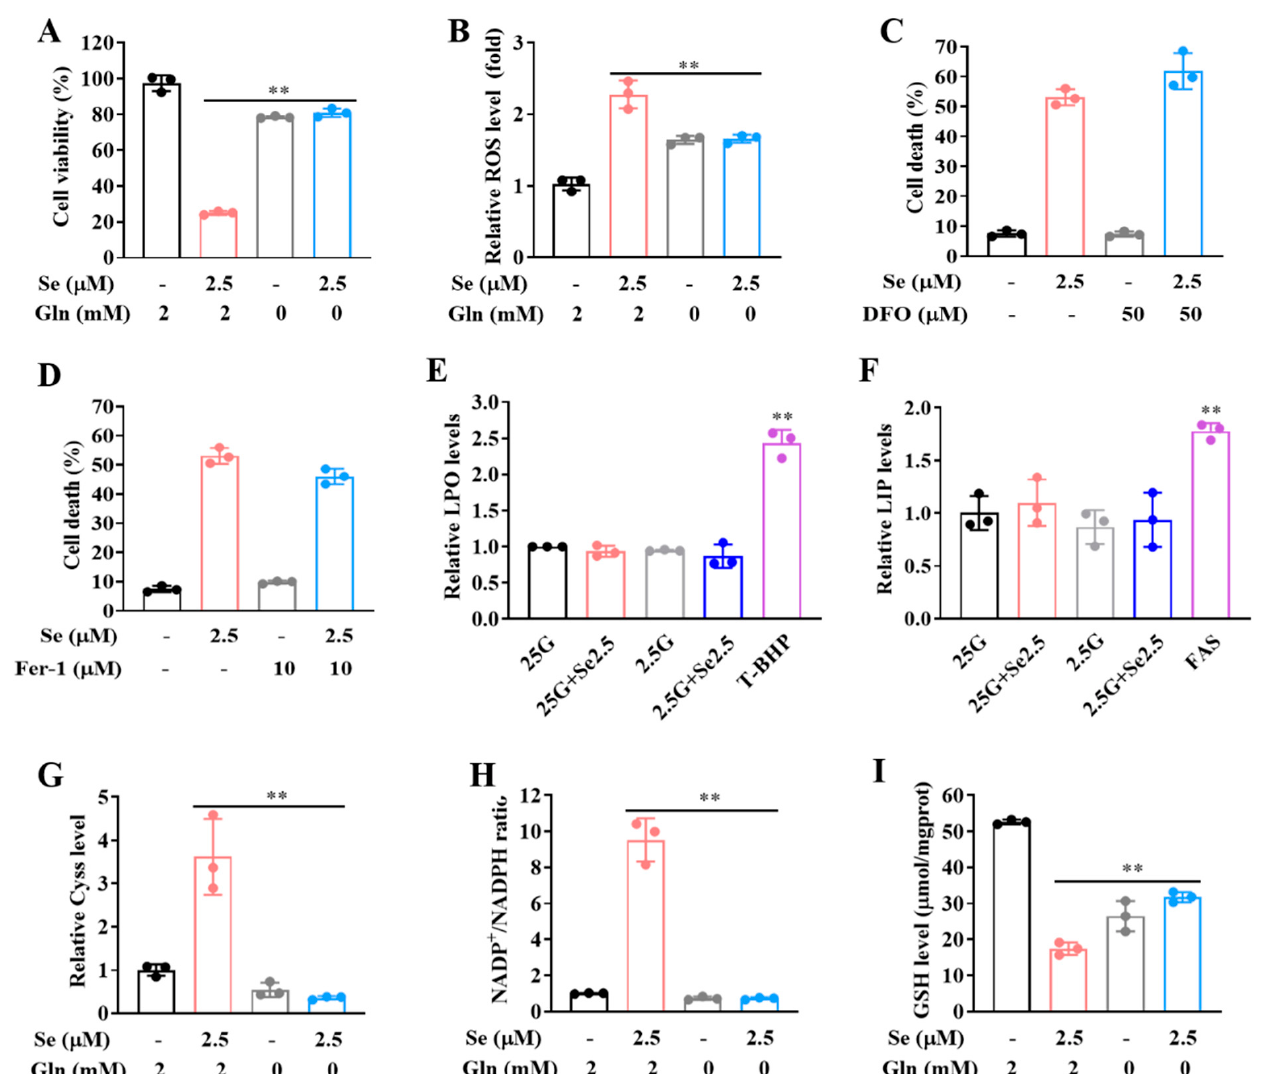
Figure 5. Selenite/glucose deprivation ‐ induced cytotoxicity is independent of ferroptosis. ( A , B ) Cell viability ( A ) and O 2 •− levels ( B ) of HCT116 cells cultured in the medium containing 2.5 mM glucose with or without treatment of selenite or glutamine deprivation for 24 h ( A ) and 22 h ( B ). ( C , D ) Cell death of HCT116 cells cultured in the medium containing 2.5 mM glucose with or without treatment of selenite or DFO or Fer ‐ 1 for 24 h. ( E , F ) LPO levels ( E ) and LIP levels ( F ) of HCT116 cells cultured in the medium containing 2.5 mM glucose with or without treatment of selenite for 22 h. Cells cultured in the medium containing 2.5 mM glucose were treated by 1 mM T ‐ BHP or 200 μ M FAS for 30 min before detection. ( G – I ) Cyss levels ( G ), NADP+/NADPH ratios ( H ) and GSH level ( I ) of HCT116 cells cultured in the medium containing 2.5 mM glucose with or without treatment of selenite or glutamine deprivation for 22 h. Results are representative of three biologically independent experiments. Data are expressed as mean ± SD, ** p < 0.01. Gln: glutamine; DFO: deferoxamine mesylate; Fer ‐ 1: ferrostatin ‐ 1; LPO: lipid peroxidation; LIP: labile iron pool; T ‐ BHP: tert ‐ butyl hydroperoxide; FAS: ferrous ammonium sulfate; Cyss: cystine; NADP+: oxidized form of nicotinamide ‐ adenine dinucleotide phosphate; NADPH: reduced form of nicotinamide ‐ adenine dinucleotide phosphate; GSH: glutathione.